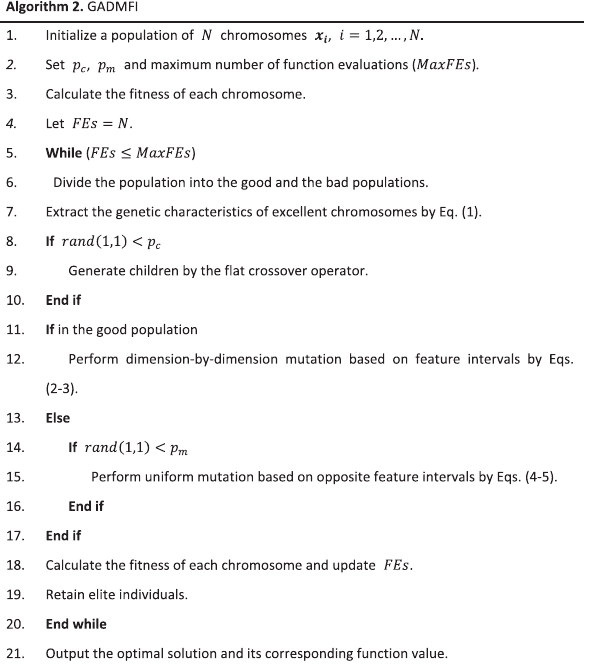
TABLE 2 | The pseudo-code of the proposed